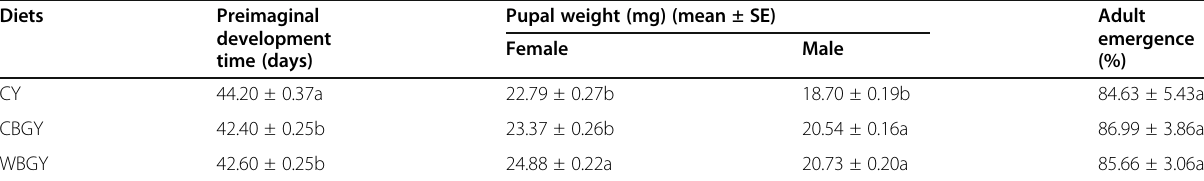
Table 2 Biological traits of Ephestia kuehniella when fed on three diets Diets